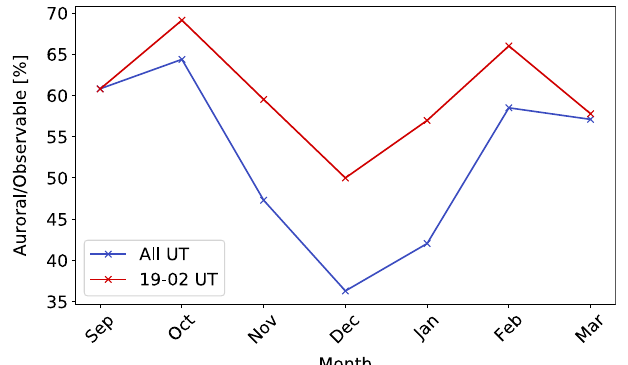
Figure 6. Monthly variation in the occurrence rate of aurora for all UT (blue line) and 19 to 02 UT only (red line). During 19 to 02 UT, the sky is completely dark in all the months from September to March in Tromsø. In both lines, the occurrence rate is the lowest in December, which includes the winter solstice, and it is high near the spring and autumn equinoxes.